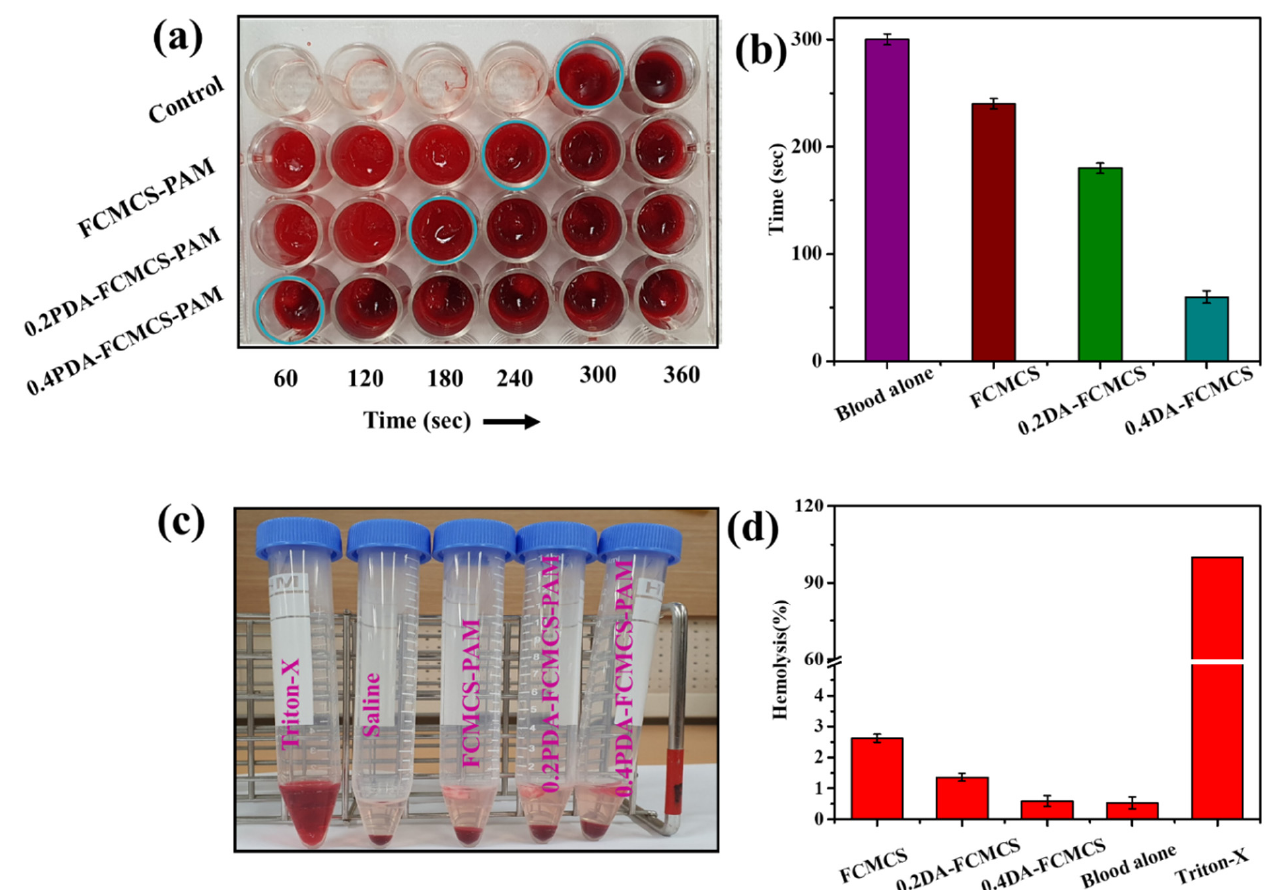
Figure 11. ( a ) Digital photograph images of blood clotting, ( b ) blood clotting time of hydrogels, ( c ) digital photograph images of hemolysis, and ( d ) % hemolysis of hydrogels.